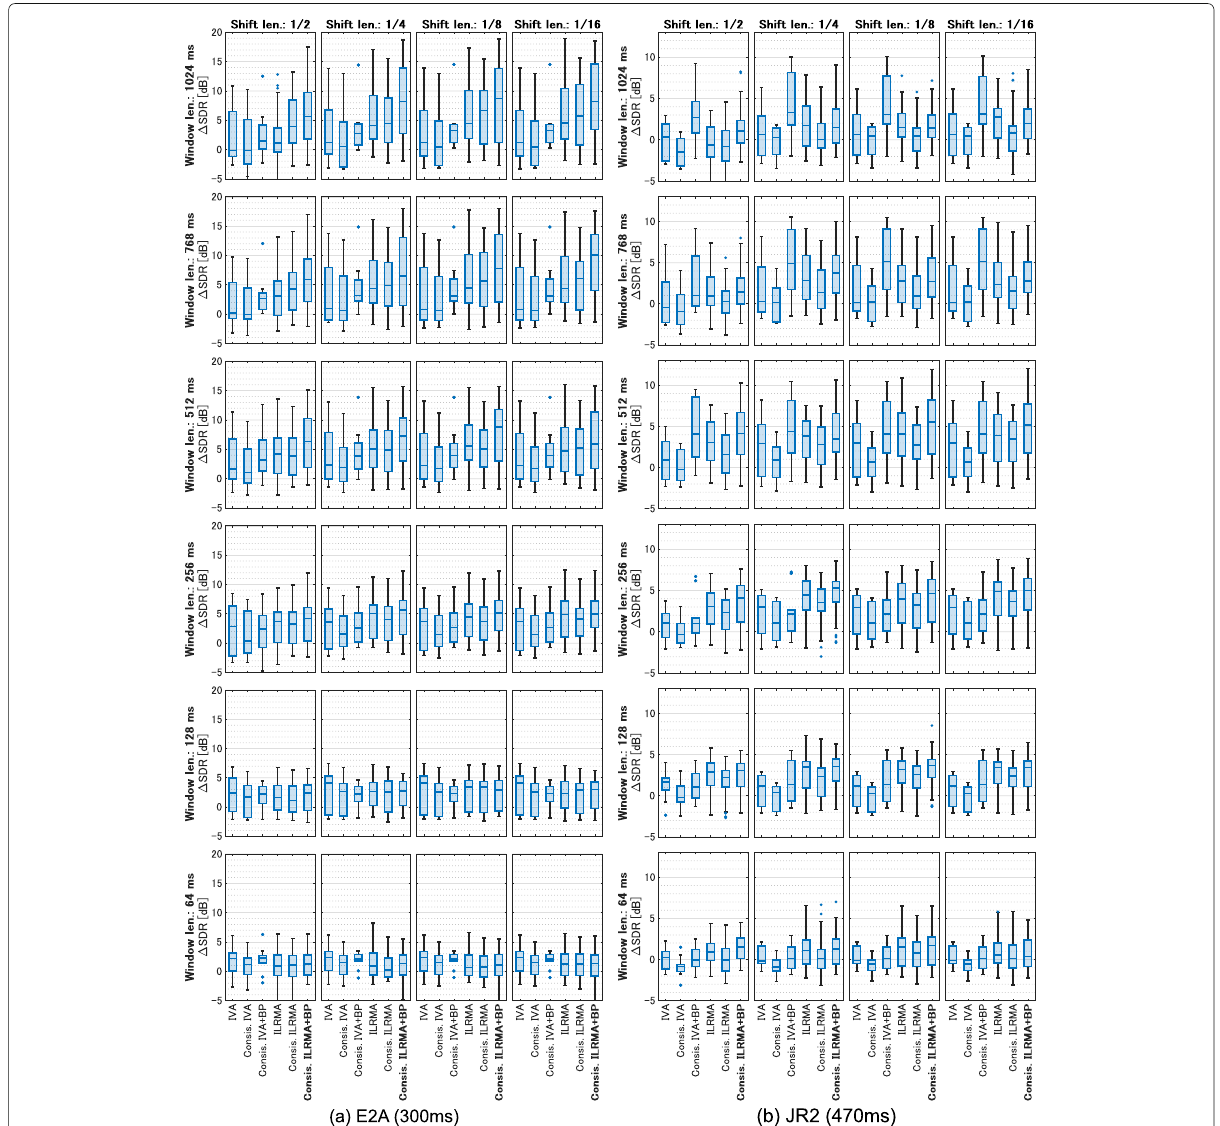
Fig. 9 Average SDR improvements for synthesized speech mixtures (speech 1–10) with a E2A and b JR2 , where Hann window is used in STFT